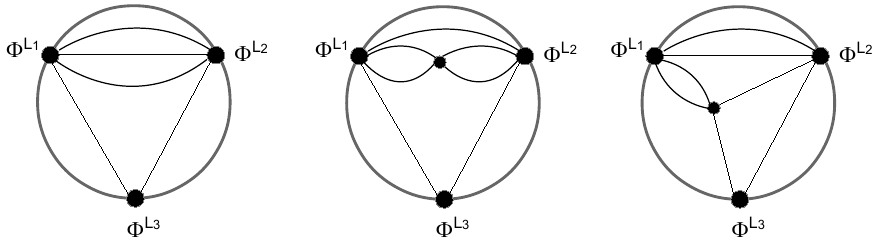
Figure 6 . Topology of Witten diagrams contributing to the 3-point function of general length operators (in the picture the case L 1 = L 2 = 4 ; L 3 = 2 is shown). In addition, there are one-loop corrections to the generalized free-(cid:12)eld diagrams shown on the